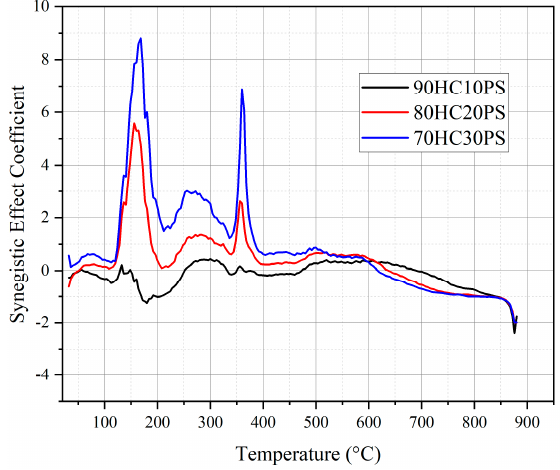
Figure 6. Degree of synergy towards DTG curves for 90HC10PS, 80HC20PS, and 70HC30PS fuel samples at 12.5 °C/min heating rate under an air atmosphere.